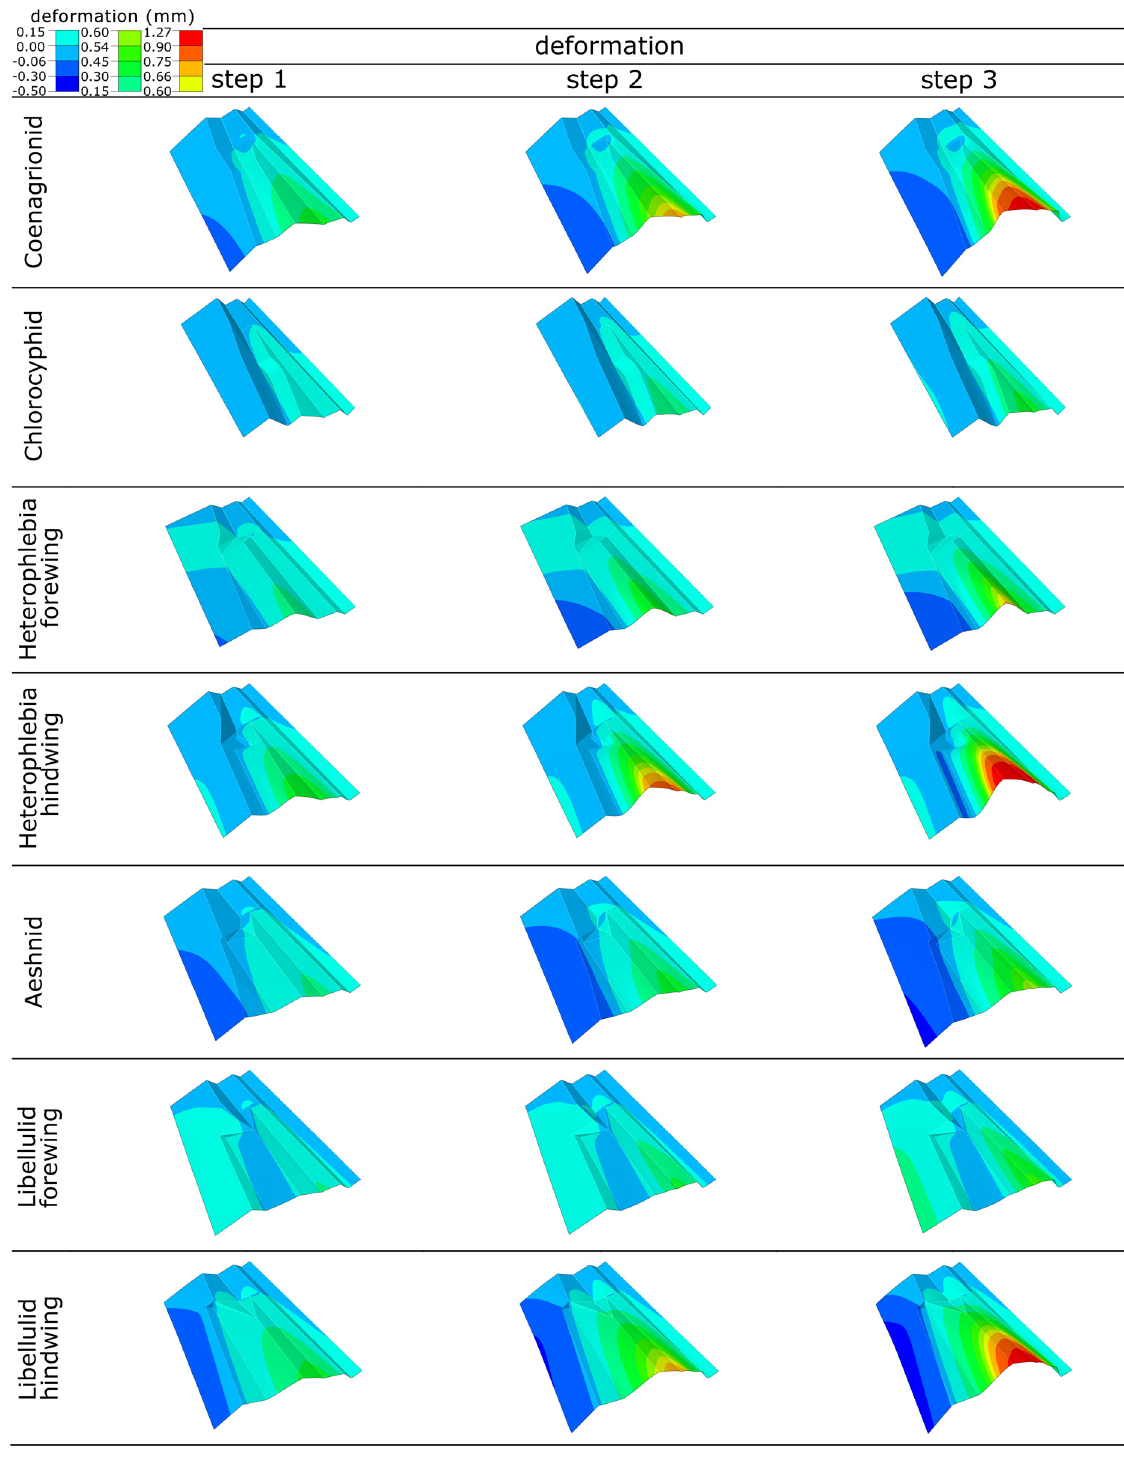
Fig 4. Selected snapshots of the deformation pattern of the realistic wing models (Group 1). The different configurations of the basal complex result in the different types and magnitudes of the deformation.